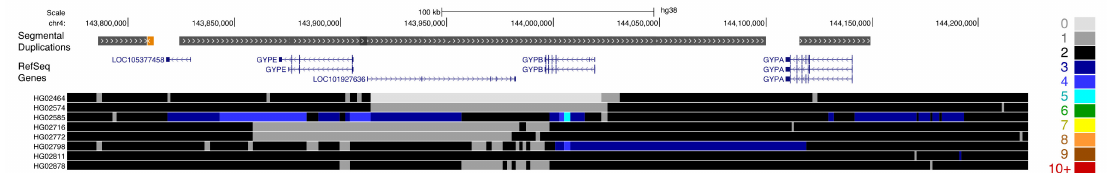
Figure 4. Variation at the glycophorin locus in the Gambian in Western Divisions (GWD) population. Paralog-specific copy-number estimates are shown for eight individuals at the glycophorin locus on chromosome 4. One sample, HG02811, is predicted to have a copy number of two across the entire region, matching the depiction in the genome reference assembly. The other samples show complex patterns of deletion and duplication involving portions of GYPE , GYPB , and GYPA . The browser display and heatmap image is formatted as depicted in Figure 3.